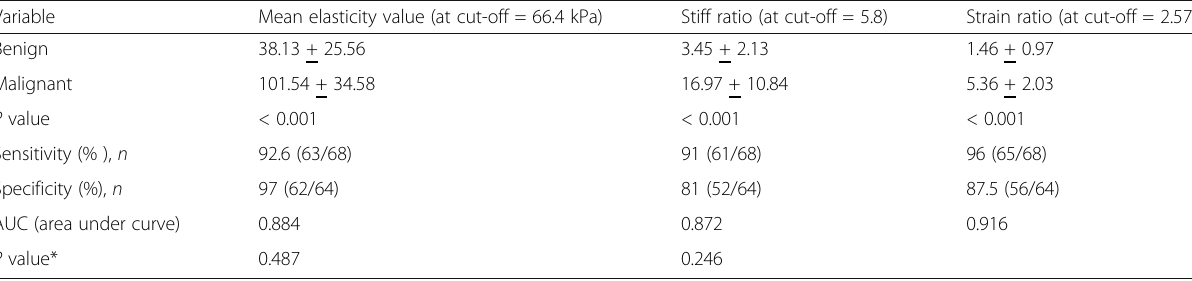
*Comparison of AUC of mean elasticity value and stiff ratio with the strain